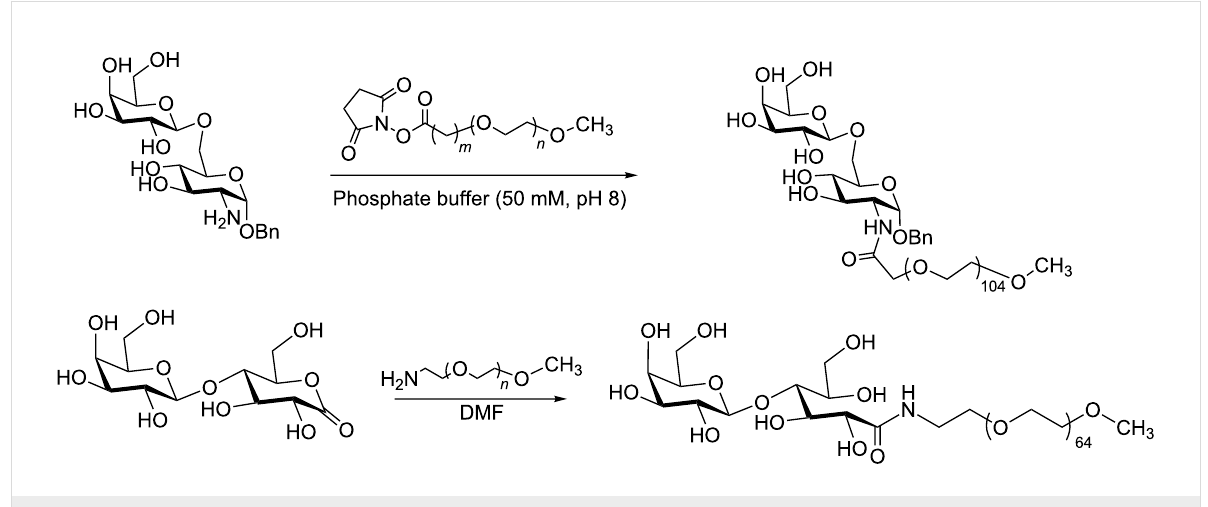
Scheme 7: PEGylation of lactose analogs